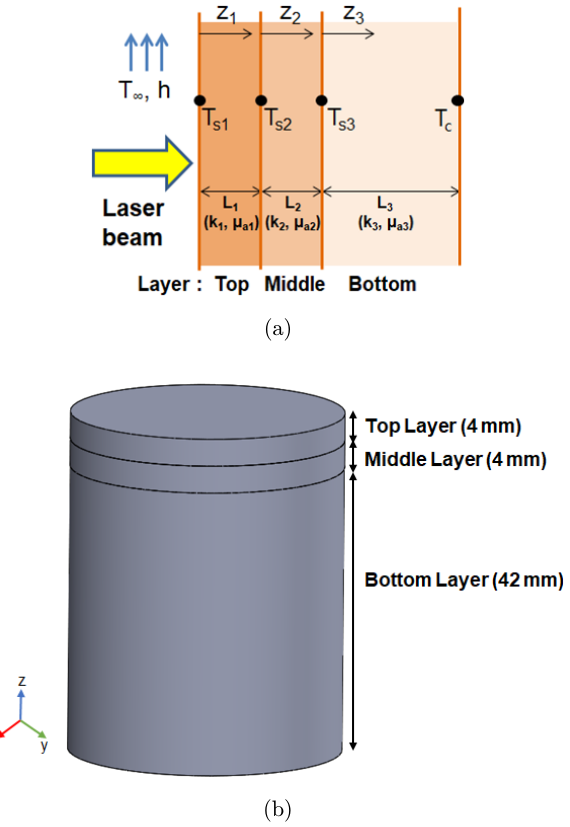
Fig. 3. (a) Schematic of the three-layer tissue phantom for the mathematical modeling of the temperature distribution and (b) 3D computational model used for simulation. The layers are assumed to have di®erent optothermal properties.